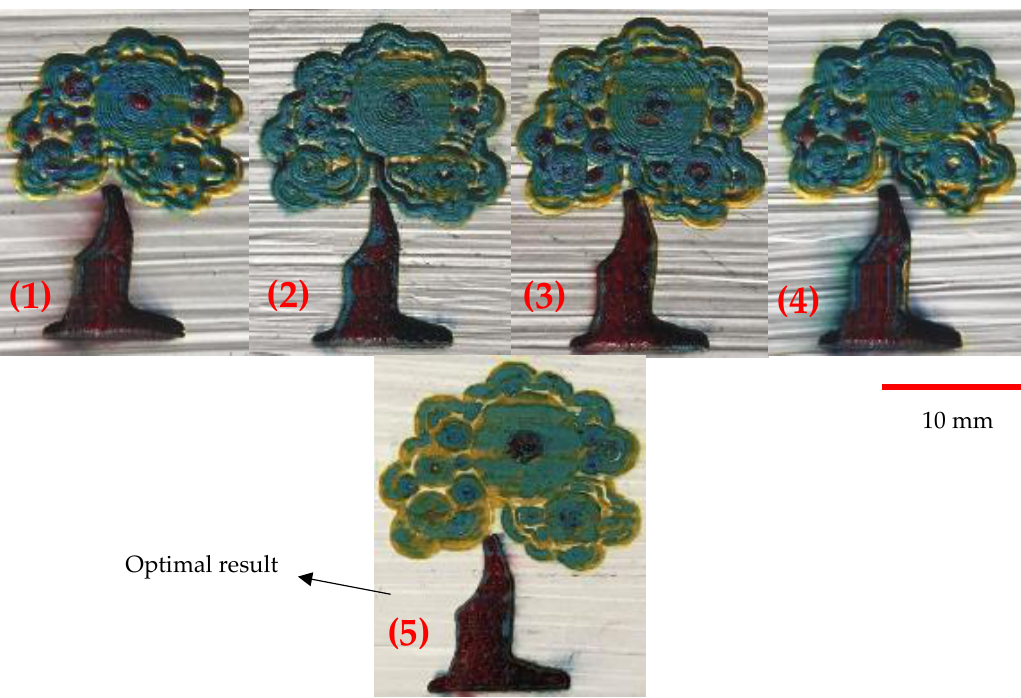
Figure 21. Different color designs of tree, 1–4: Different laser parameters (Table 3), 5: Optimum parameters (Table 4).